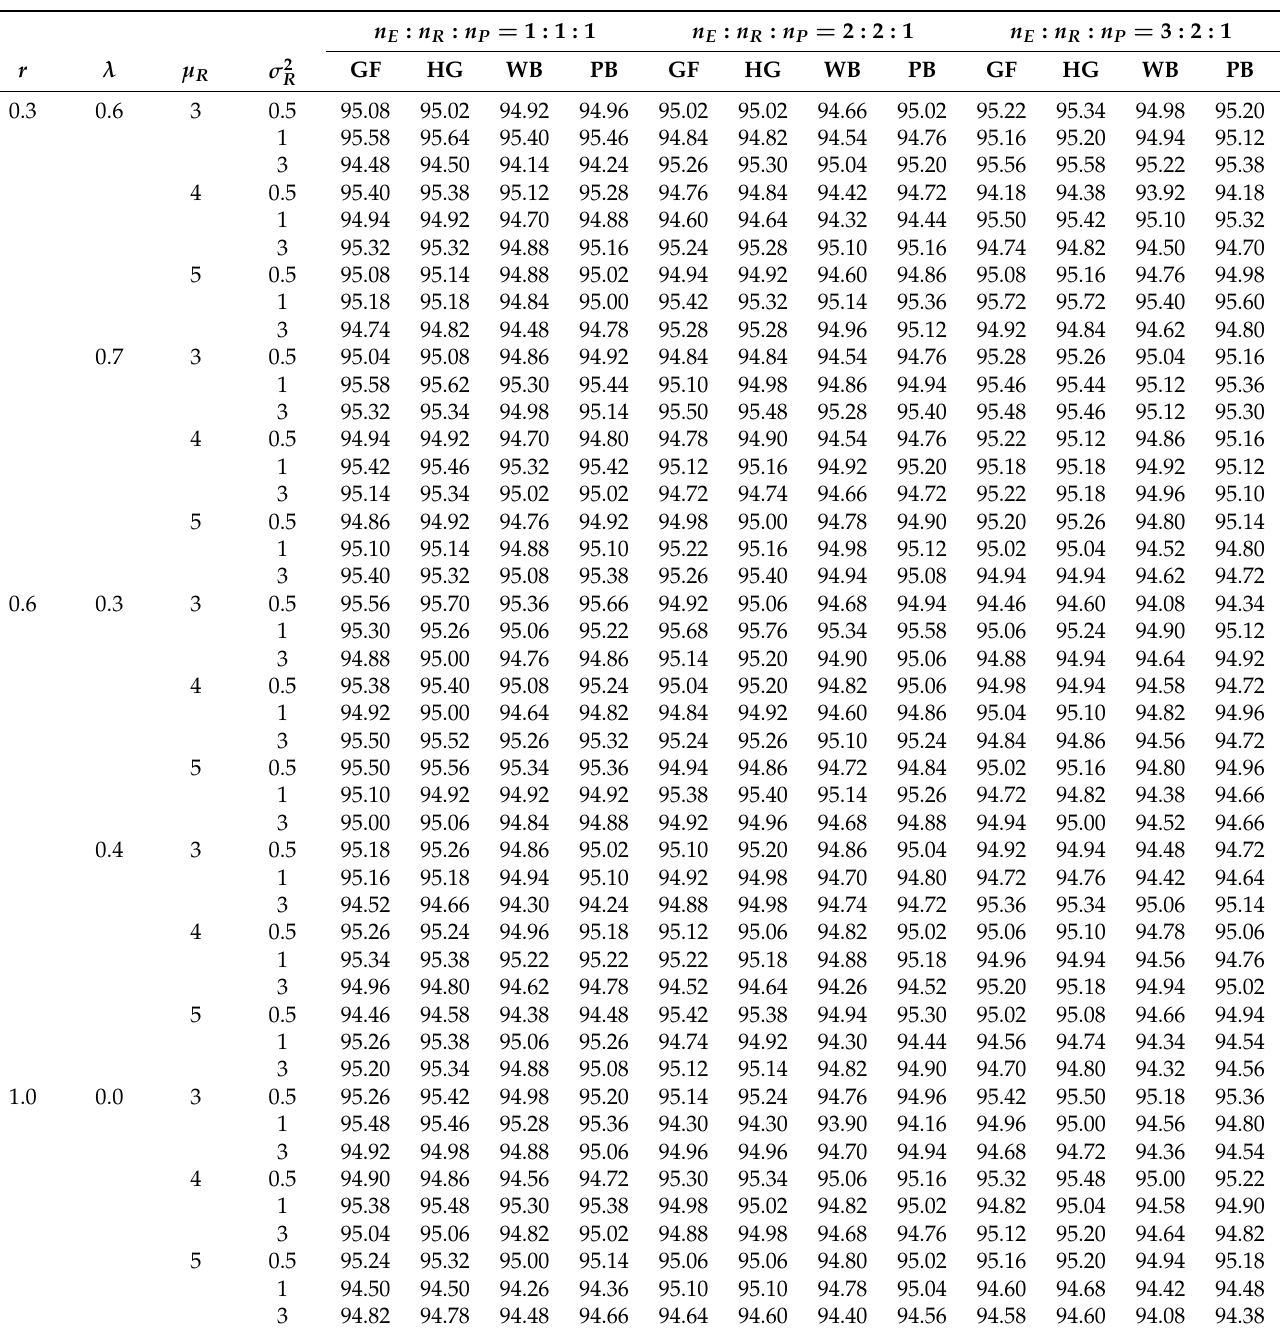
Table 3. Empirical coverage probabilities of four 95% simultaneous confidence regions for φ and ψ under various settings with n =